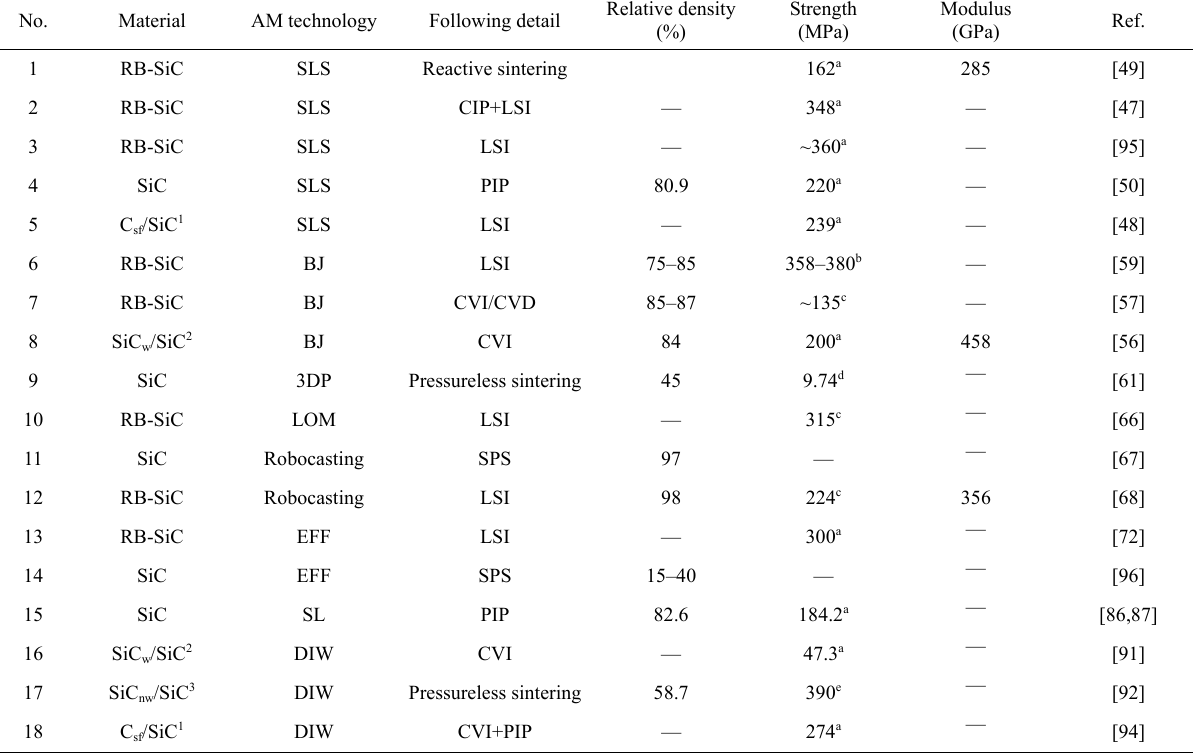
Table 2 Comparison of the relative density and strength of SiC ceramic fabricated by different additive manufacturing techniques